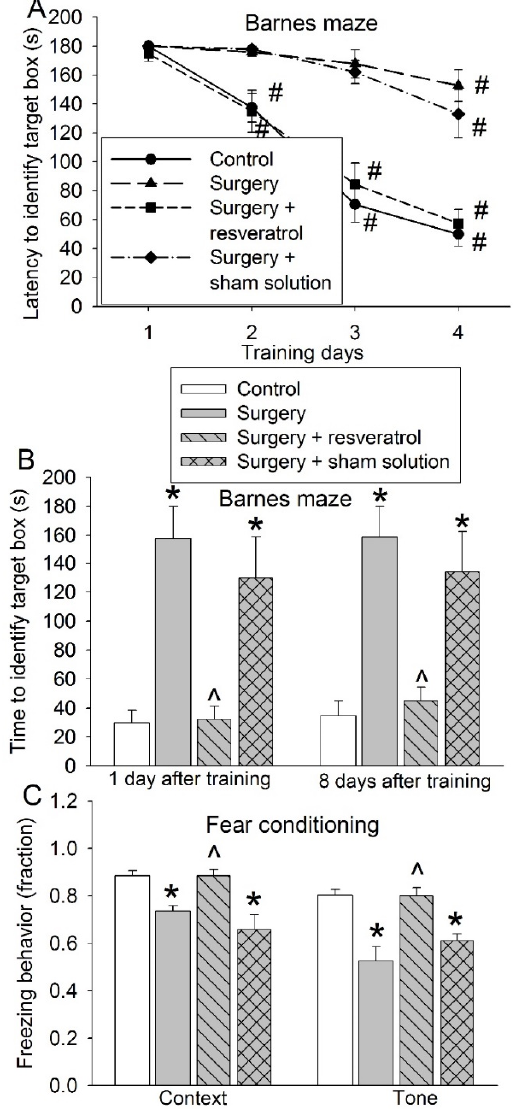
Figure 8. Effects of resveratrol and surgery on learning and memory. Eighteen-month-old mice were subjected to right carotid artery exposure and received resveratrol for 7 days. They started to be tested by the Barnes maze and fear conditioning 2 weeks after surgery. ( A ) Performance during the training sessions of the Barnes maze test. ( B ) Performance during the memory phase of the Barnes maze test. ( C ) Performance in the fear-conditioning test. Results are means ± S.E.M. ( n = 9–